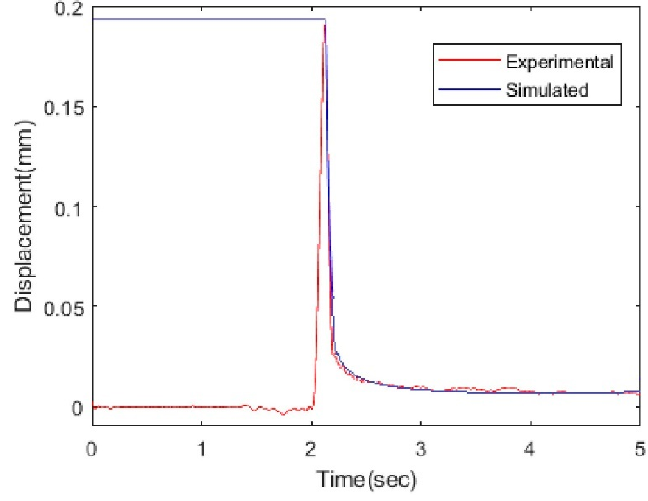
Figure 25. Step response of conductive material without VCA.